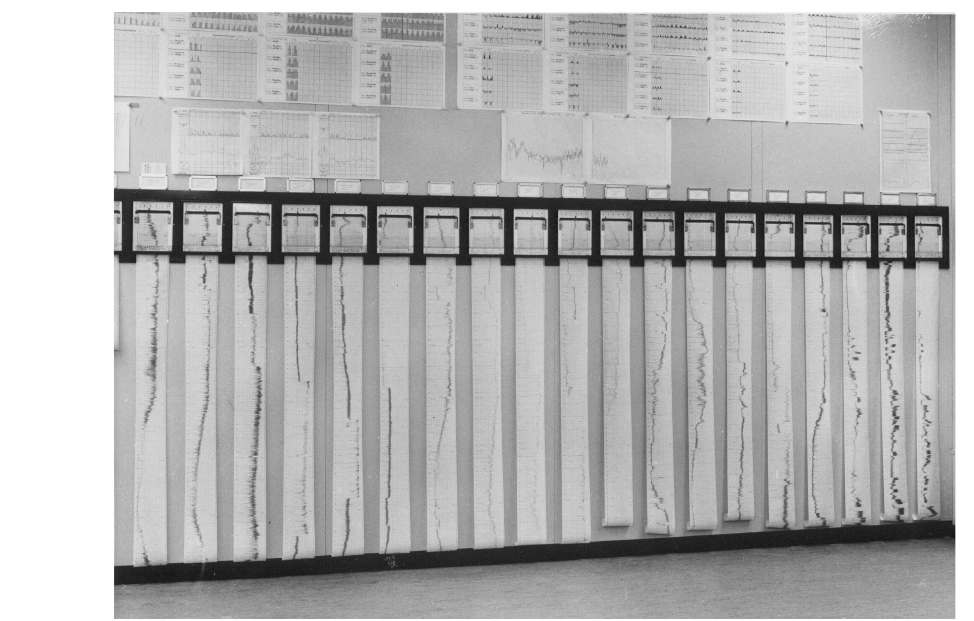
Figure 1. The signal strength of up to 26 distant transmitters was recorded in real time at RWC Darmstadt.